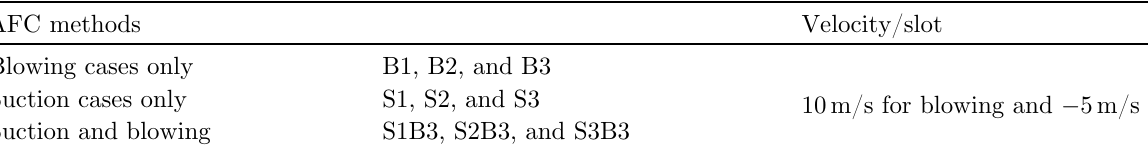
Table 4. Blowing and suction con fi gurations setup.